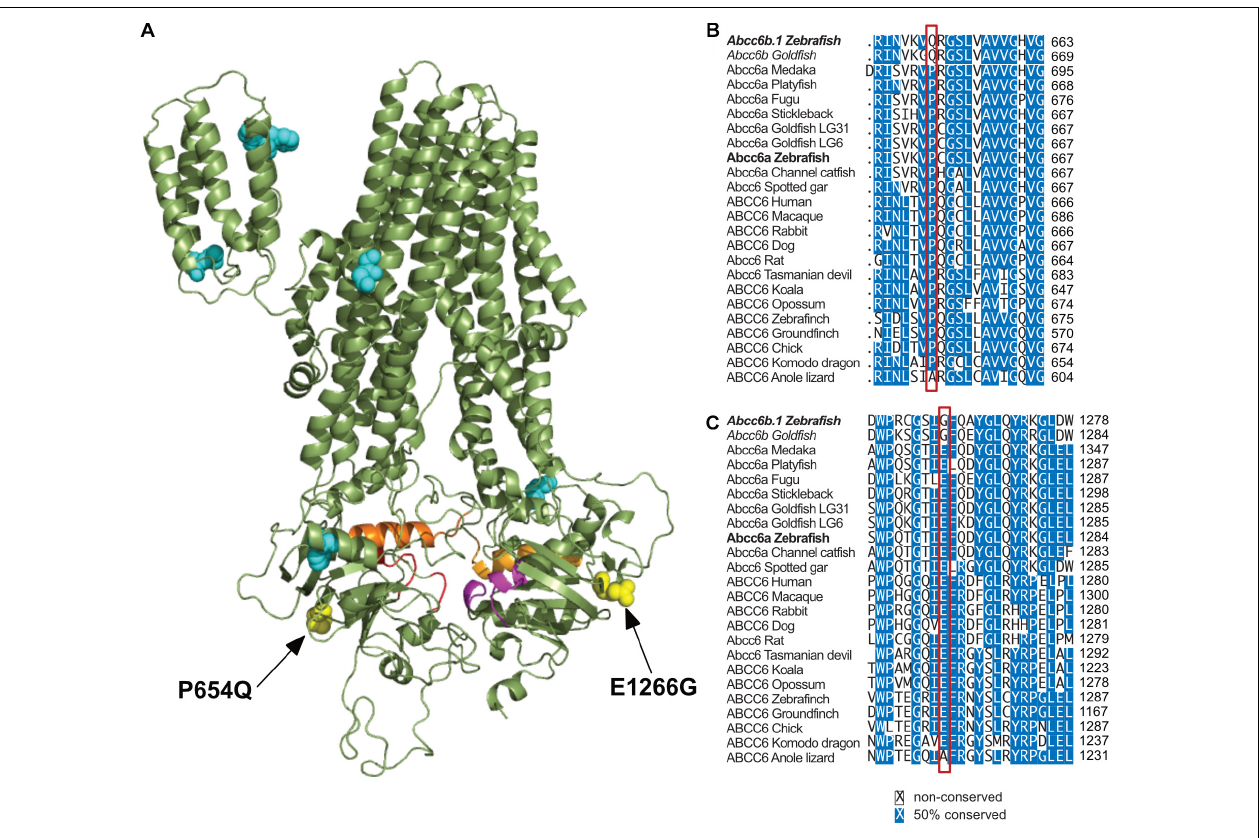
FIGURE 4 | Significant differences in between Abcc6b.1 and canonical ABCC6 sequences. (A) Homology model of ABCC6, with conserved residues that are changed in Abcc6b.1 highlighted. (B) Alignment of multiple ABCC6 orthologs with the P654Q change highlighted by the red box. (C) Alignment of multiple ABCC6 orthologs with the E1266G change highlighted by the red box. These alignments show that P654 and E1266 are almost universally conserved across vertebrates, suggesting that they are important for the function of ABCC6. (Alignments of residues highlighted in cyan in A are detailed in Supplementary Figure 4